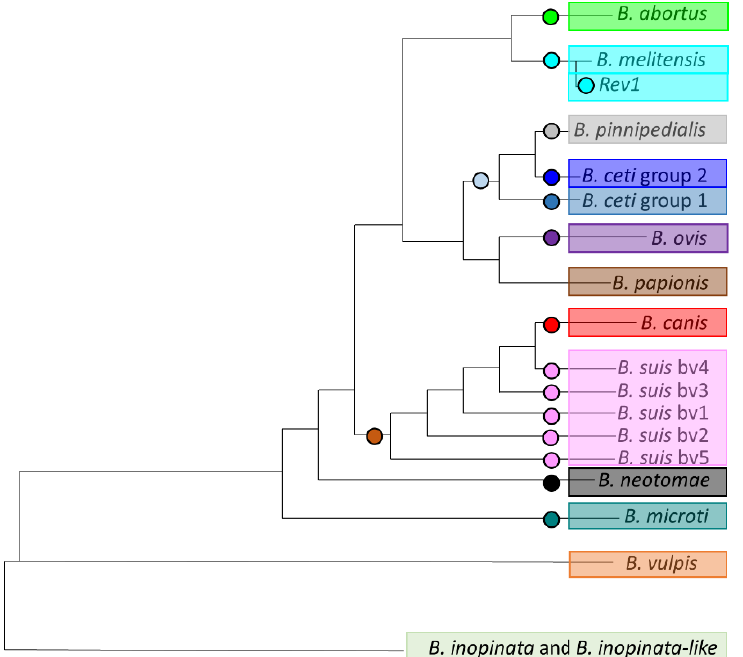
Figure 2. Position of 17 selected single nucleotide polymorphisms (SNPs) for high-resolution melting (HRM)-PCR on phylogenetic tree of Brucella . This figure represents a simplified phylogeny of Brucella genus. Each circle represent a fixed SNP selected on branch for identification of related species or biovar.